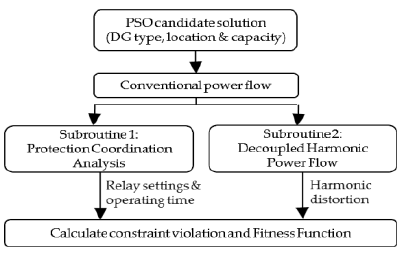
Figure 3. Framework of fitness evaluation sequence using PSO technique.